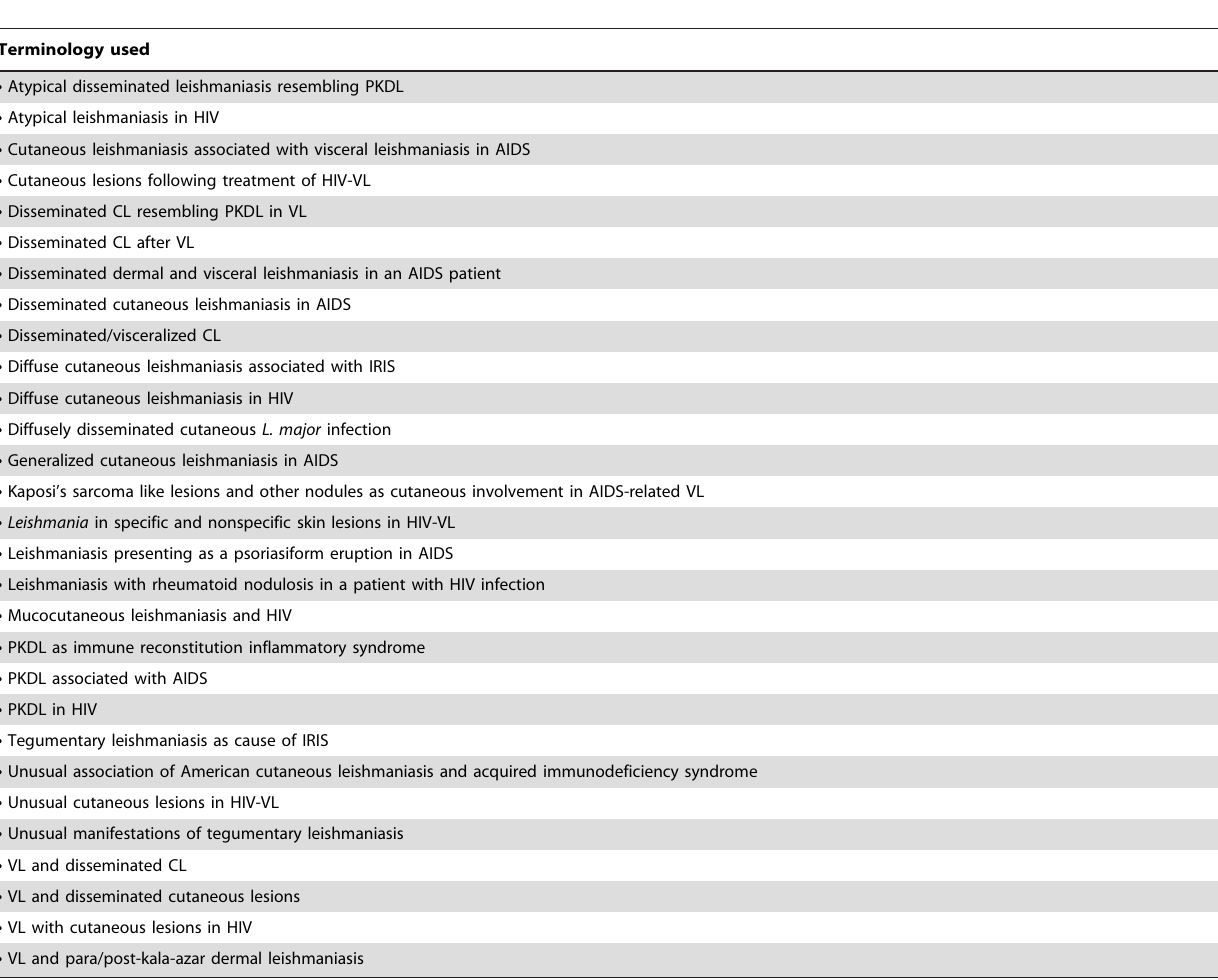
Table 1. Examples of terminology used in the literature to describe (muco-)cutaneous involvement by Leishmania in HIV co- infected